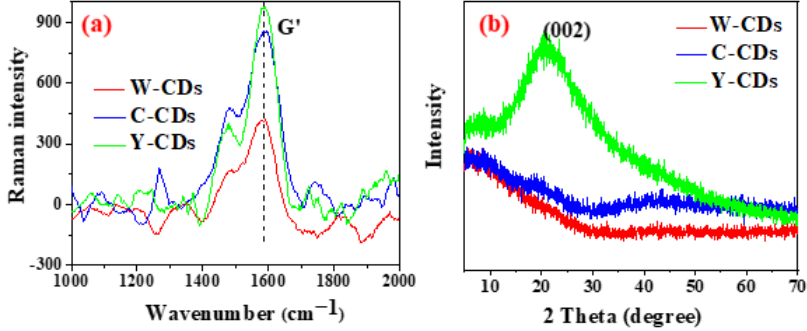
Figure 4. Raman spectrum ( a ) and XRD pattern of the synthesized CDs ( b